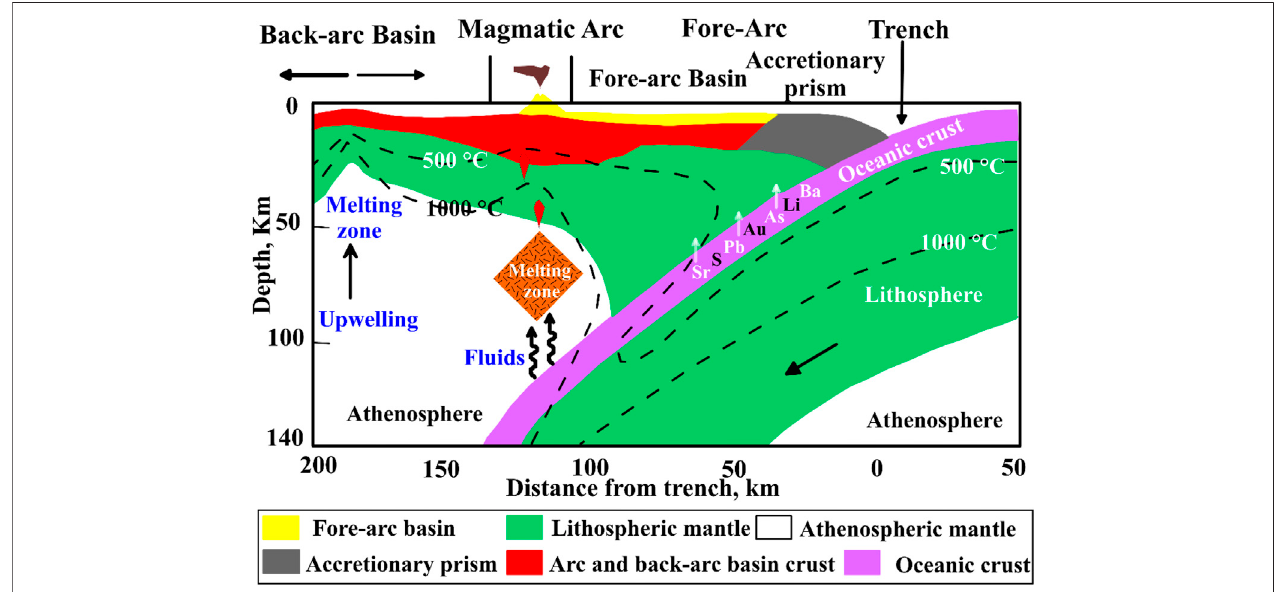
FIGURE 18 | Cartoon showing the tectonic setting of Tilal Al-Qulieb metasomatized peridotites in the fore-arc environment (modi fi ed after Azer and Stern 2007).